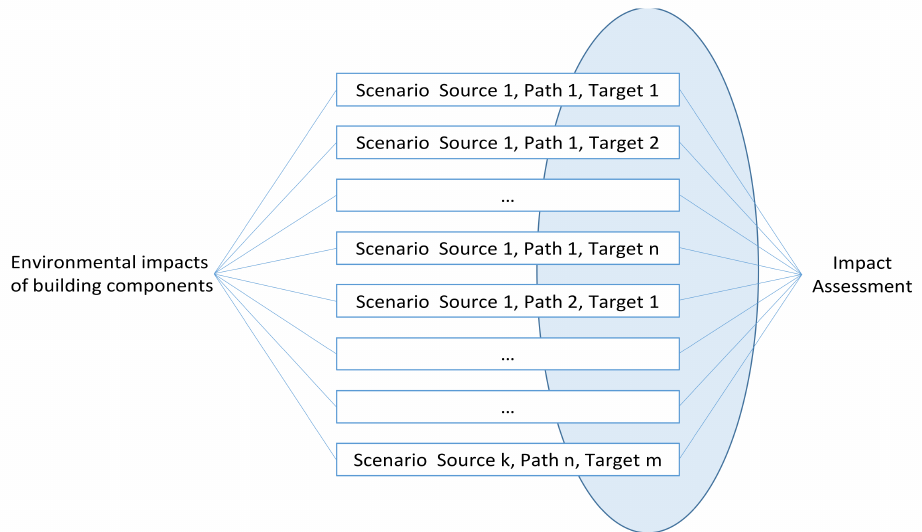
Figure 5. The Brunswikian lens model [44] of an impact assessment: The source–path–target concept determines which scenarios must be considered. Not all theoretically possible combinations of the k sources, the n paths and the m targets are relevant for the impact